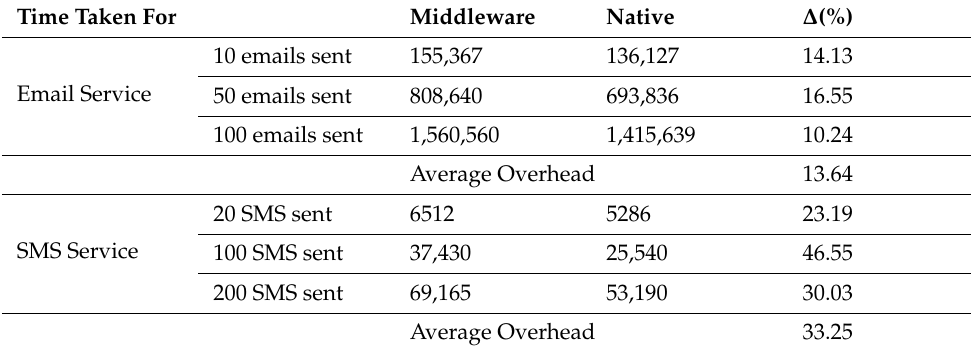
Table 3. Values of the Latency Times for Email and SMS service.